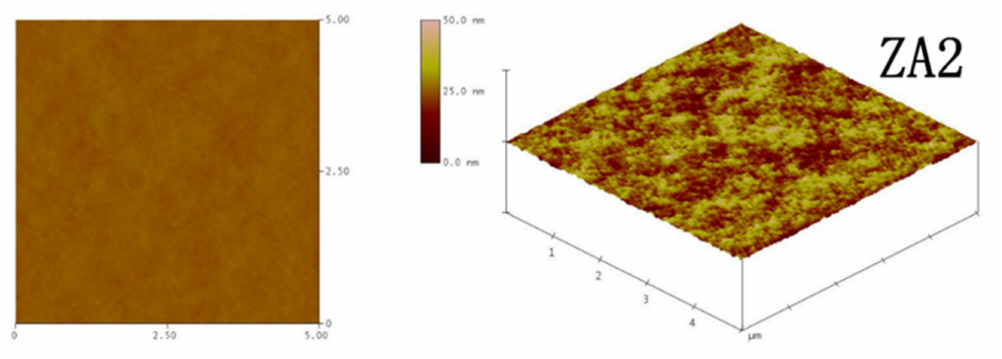
Figure 14. AFM diagram of ZA2 composite